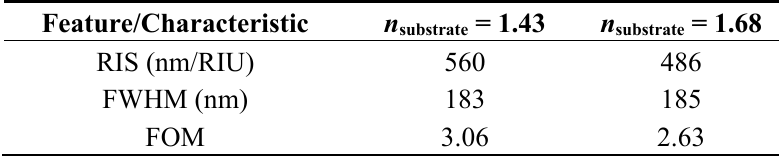
Figure 3. Effect of the substrates’ refractive indexes on the sensitivity of the hybrid nanostructure arrays. Extinction spectra in different media for substrate with refractive index of ( a ) 1.43; ( b ) 1.57; ( c ) 1.68; ( d ) 1.74; and ( e ) 1.80; and ( f ) for refractive index sensitivity curves. Table 1. Comparisons of refractive index sensitivity (RIS), width at half maximum (FWHM), and figure of merit (FOM) using two different